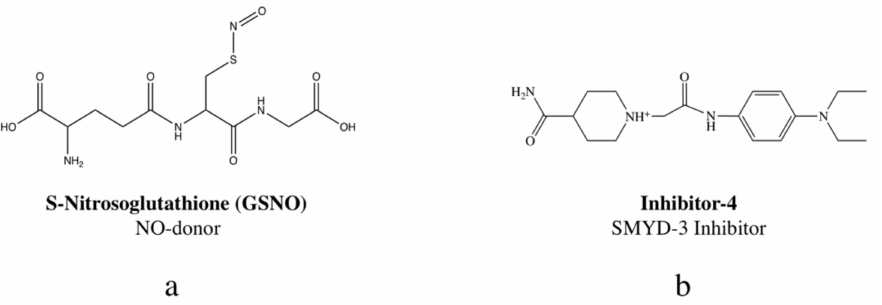
Figure 1. Structures of S-Nitrosoglutathione (( a ) GSNO; NO-donor) and inhibitor-4 (( b ) SMYD-3